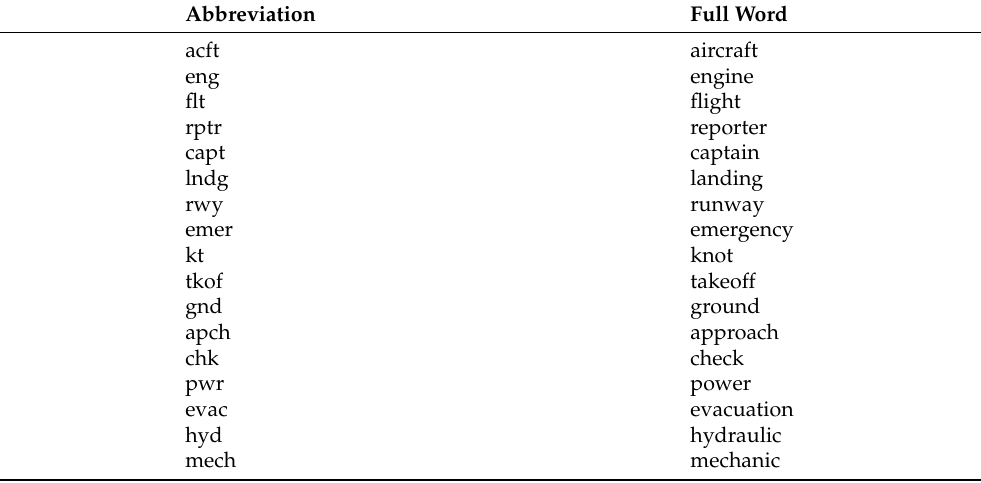
Table 1. Preprocessed abbreviations